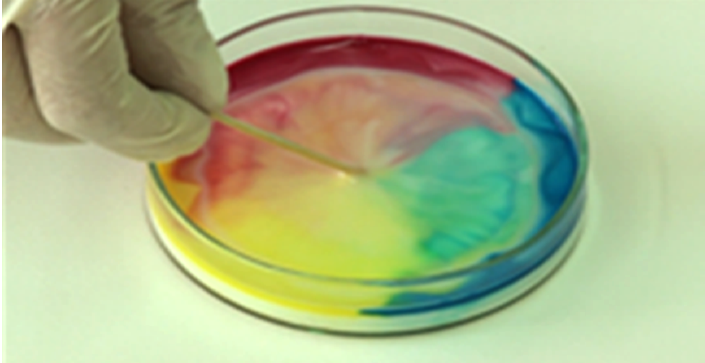
Figure 2. By dropping detergent in the centre the attraction by the water molecules